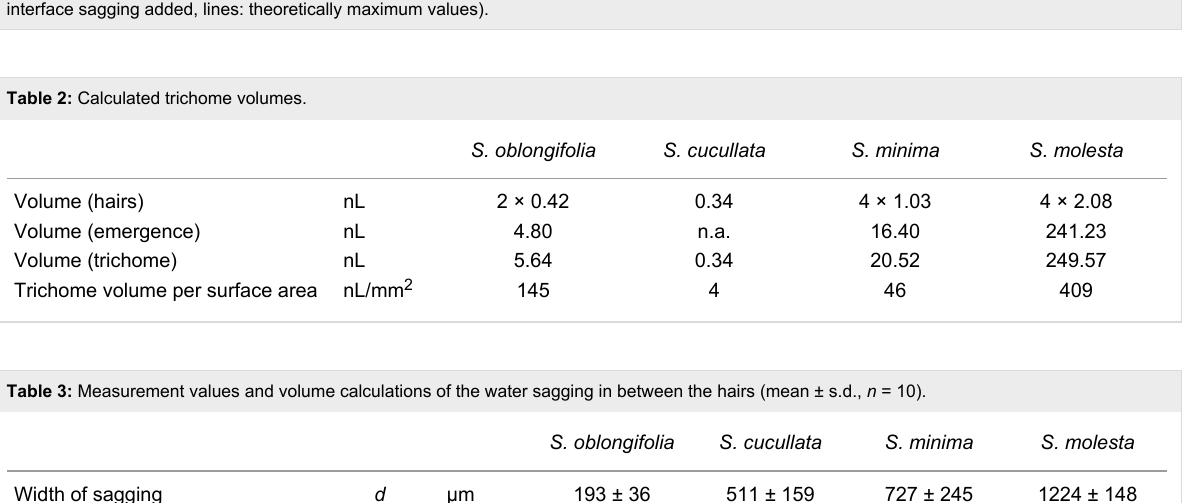
Figure 3: Air volume per surface area measured on four different Salvinia species compared to the calculated theoretically maximum values. (symbols: median values, whiskers: 95% confidence interval, grey symbols: measured values with calculated values for hair volume and air–water interface sagging added, lines: theoretically maximum values).